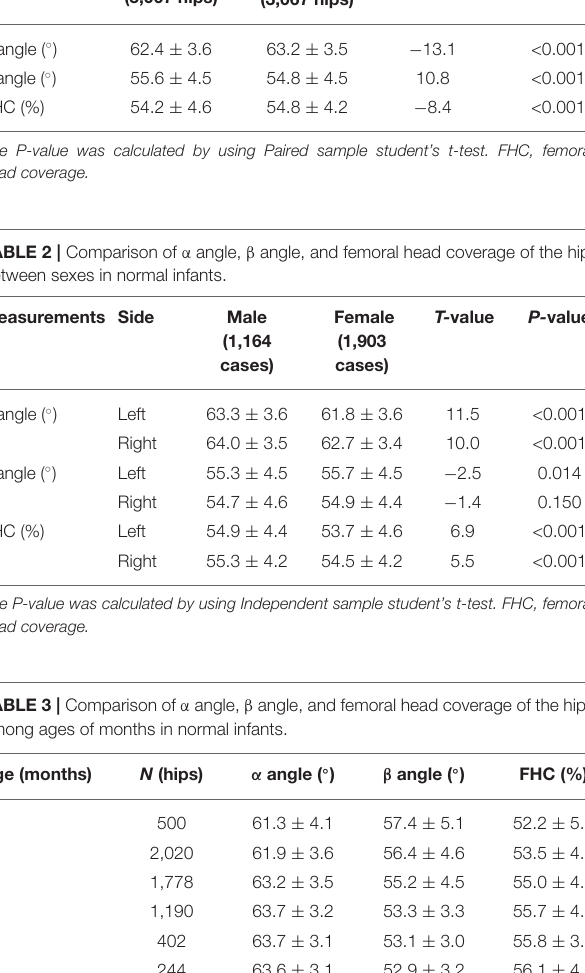
The P-value was calculated by using ANOVA test. FHC, femoral head